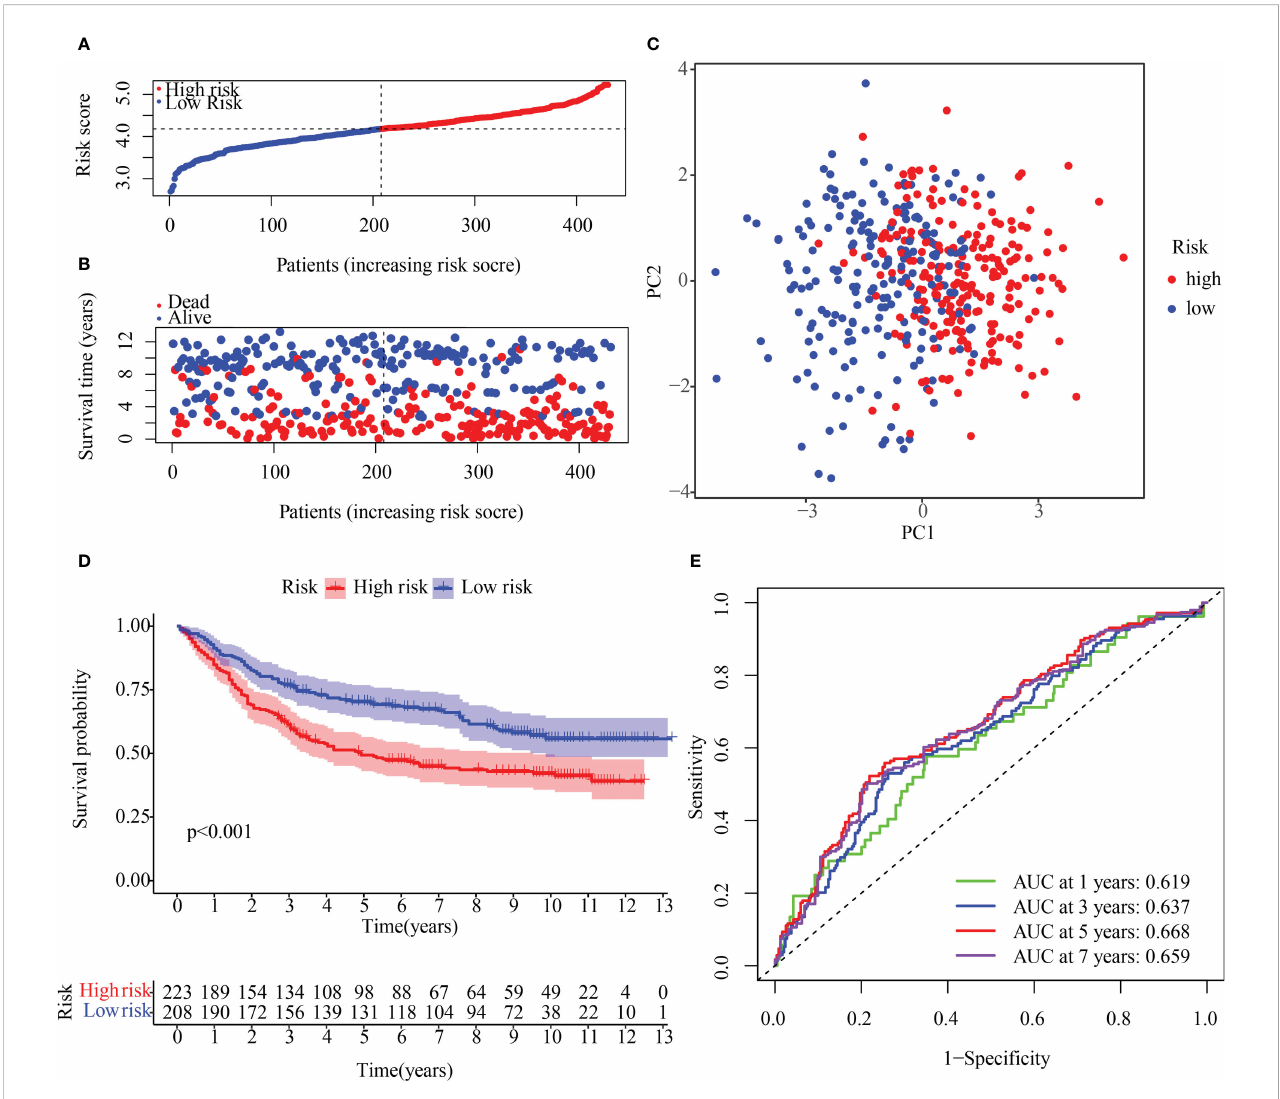
FIGURE 8 Internal validation of the OMRG-related signature in the test cohort (A) The test cohort was subdivided into various subgroups. (B) The survival rate of the test cohort as well as the distribution of risk scores (C) Principal component analysis was performed on the test1 cohort. (D) Survival curve of the testing cohort. (E) AUC values of ROC curves in the test